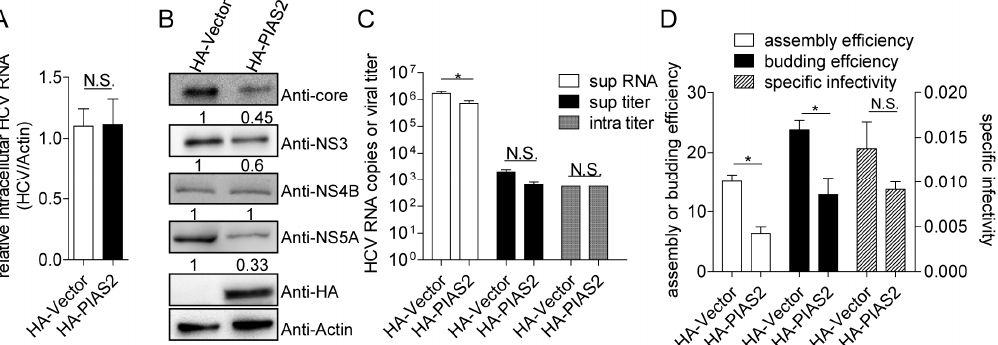
Figure 2. Exogenously expressed PIAS2 inhibits HCV replication. Huh7 cells were transfected with plasmids as indicated and then infected with J399EM at an MOI of 0.1 for 72 h. ( A ) The relative intracellular HCV RNA levels were determined by real-time RT-PCR; ( B ) the HCV core, NS3, NS4B, NS5A protein and HA-tagged PIAS2 expression levels are shown; ( C ) the HCV RNA level in the supernatant (super RNA), viral titer in the supernatant (super titer), and intracellular viral titer (intra titer) were determined; ( D ) the assembly efficiency, budding efficiency, and specific infectivity were calculated, * p < 0.05.